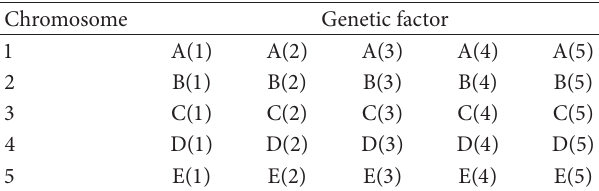
Table 2: Chromosomes before cross-interference. Chromosome Genetic factor